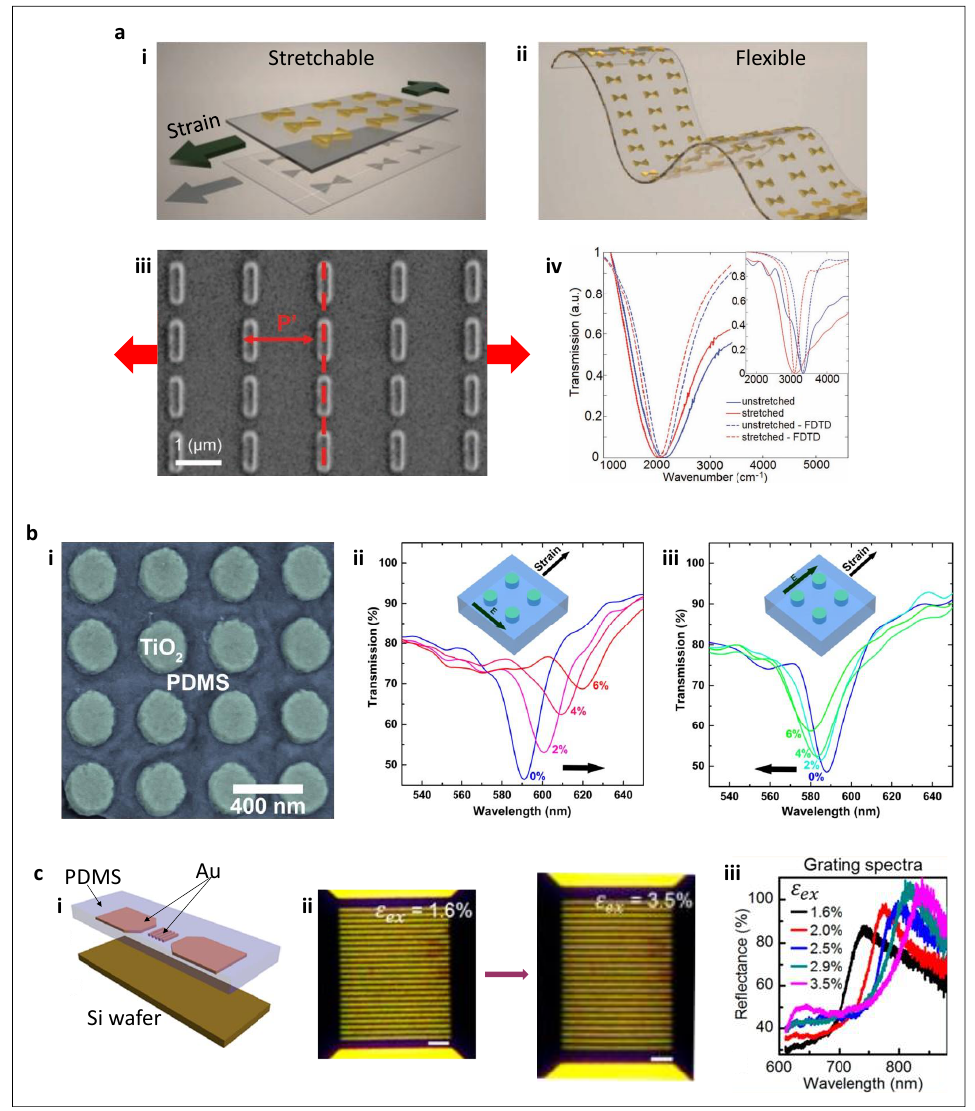
Figure 6. Mechanical tuning of plasmonic resonance. ( ai ) Illustration of a stretchable metasurface fabricated by nanostencil lithography. ( aii ) Illustration of a flexible metasurface fabricated by nanos- tencil lithography (bottom). ( aiii ) Illustration of uniform change in periodicity of the metasurface upon stretching. A stretch of 21.3% changes the periodicity from 1.51 [µm] to 1.83 [µm]. ( aiv ) Trans- mission spectra of unstretched and stretched conditions. When the metasurface is stretched, the resonance wavelength shifts by 160 [nm]. ( bi ) SEM image of TiO 2 embedded in PDMS metasurface. ( bii ) Polarization-dependent transmission spectra of the metasurface under different stretching ratios. A red shift can be clearly observed when the metasurface is stretched from 0% to 6% in the horizontal axis. The inset depicts the stretching phenomenon. ( biii ) Polarization-dependent transmission spec- tra of the metasurface under different stretching ratios. A slight blue shift can be clearly observed when the metasurface is stretched from 0% to 6% in the vertical axis. Inset depicts the stretching phenomenon. ( ci ) Illustration of the metasurface based on deformable PDMS (top) peeled off a silicon substrate. The metasurface consists of gold (Au) plasmonic gratings sandwiched between tapered gold microrods and encapsulated in PDMS. ( cii ) Optical microscope images of the metasurface under different stretch ratios. ( ciii ) Measured reflectance spectra of the metasurface under different stretch ratios. ( a ) Reprinted with permission from ref. [32]. Copyright (2011) Wiley & Sons, Inc. ( b ) Reprinted with permission from ref. [126]. Copyright (2016) American Chemical Society. ( c ) Reprinted with permission from ref. [127]. Copyright (2018) American Chemical